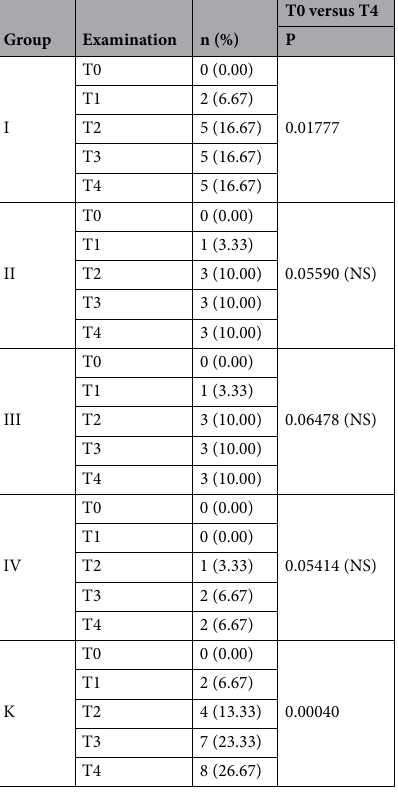
Table 3. Number of patients with WSLs in the study and control groups in subsequent